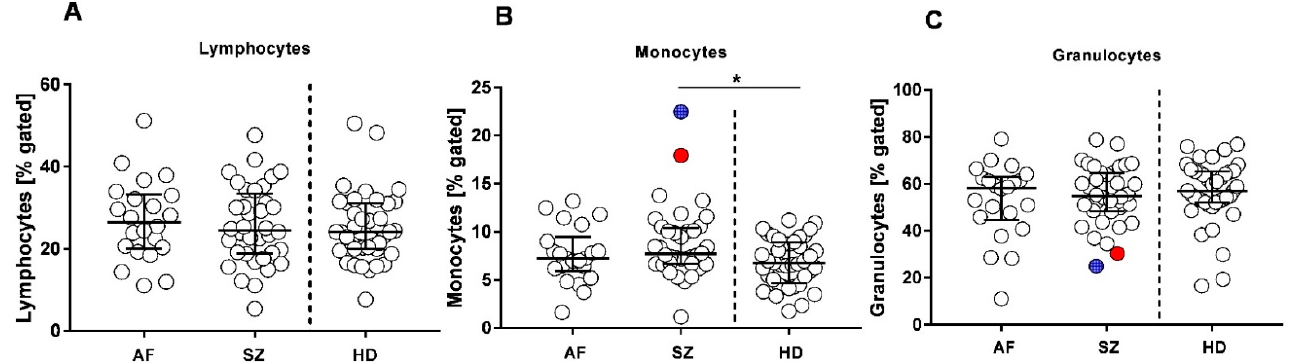
Figure 2. Relative amounts of leukocyte subpopulations in patients with AF, SZ, and HDs . Lym- phocyte ( A ), monocyte ( B ), and neutrophilic granulocyte ( C ) amounts are shown from each patient (% gated). Bars indicate the respective medians, including interquartile ranges. Two outlier patients in the SZ group are color labeled (red and blue symbols, respectively). Wilcoxon rank-sum test was performed to analyze differences among groups, with significant differences being marked by * p ≤ 0.05.